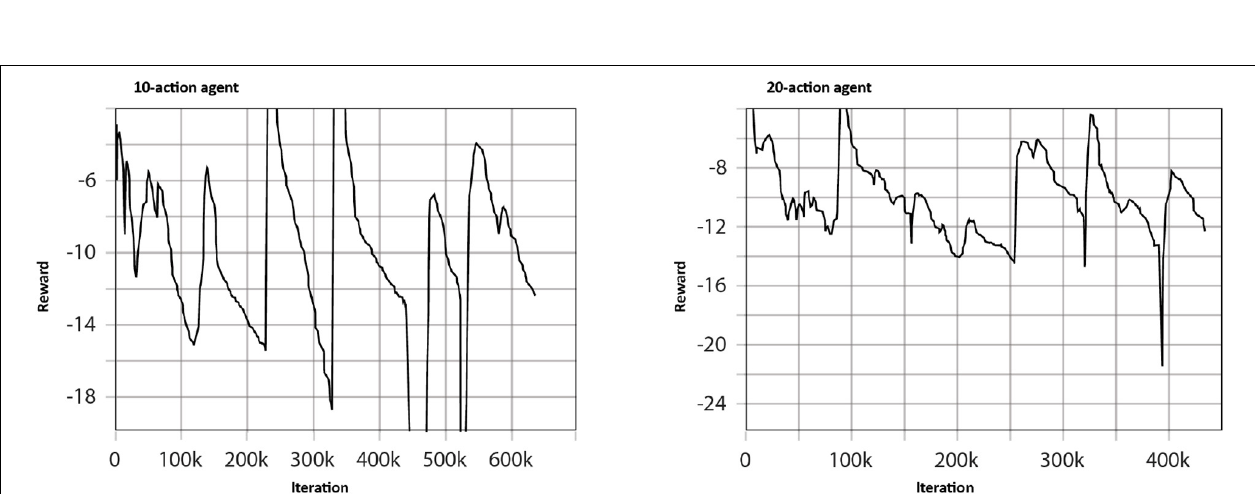
Frontiers in Ecology and Evolution |